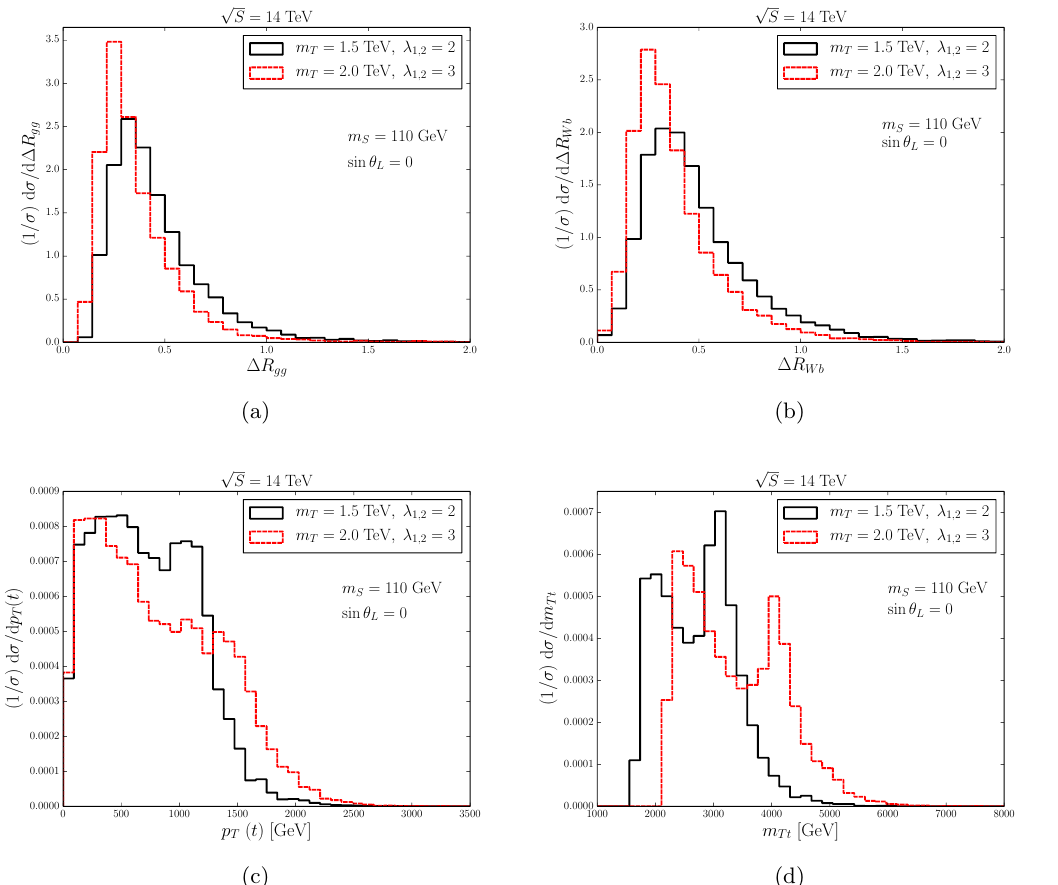
Figure 15 . (a) (cid:1) R gg distribution of the scalar decay products S gg . (b) (cid:1) R Wb distributions ! between the top quark decay products t bW originating from the top partner decay T tS . (c) ! ! Transverse momentum distribution of the top quark produced in association with the top partner pp Tt . (d) Invariant mass of the top partner and top quark that are produced together pp Tt . ! ! Distributions are at parton level and for both (black) m T = 1 : 5 TeV and (red) m T = 2 TeV. The other model parameters are set to m S = 110 GeV and sin (cid:18) L = 0. The coupling constants